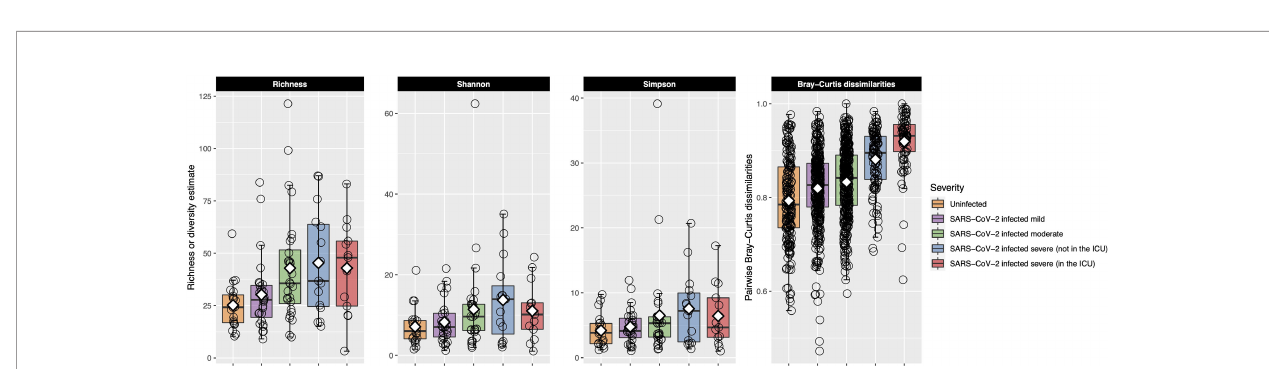
FIGURE 3 | Bacterial richness and alpha- and beta-diversity results are plotted for each of the COVID-19 severity groups. Each box represents the median and interquartile range, and the mean is shown by the white diamond. Individual points are shown as open circles. In the fi rst three facets, bacterial richness and alpha- diversity are shown for each of the patient groupings. Richness and alpha-diversity (Shannon and Simpson indices) were lowest in the uninfected control participants and generally increased as COVID-19 severity increased. Alpha-diversity (Shannon and Simpson indices) decreased in patients in the ICU with very severe COVID- 19. The last facet shows within-group pairwise Bray – Curtis dissimilarities plotted on the y -axis for each of the COVID-19 groups. Larger values indicate that the URT microbial community between the two samples was more dissimilar, while smaller values indicate the opposite. Uninfected control participants had the most similar URT microbiome to each other, while the URT microbiome within each group became more dissimilar as COVID-19 severity increased. The URT microbiomes among those with very severe COVID-19 were very dissimilar to each